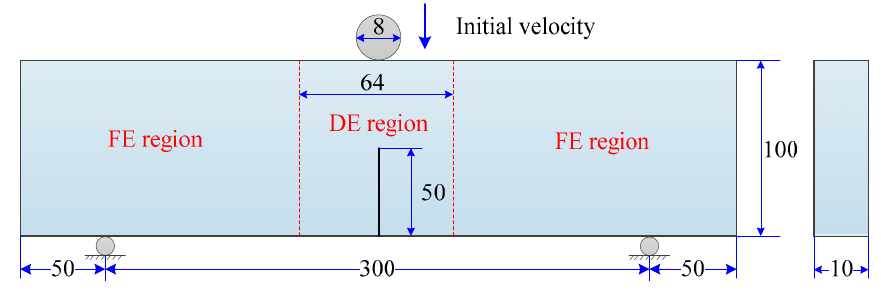
Figure 27. Geometry and loading condition of the concrete beam model.